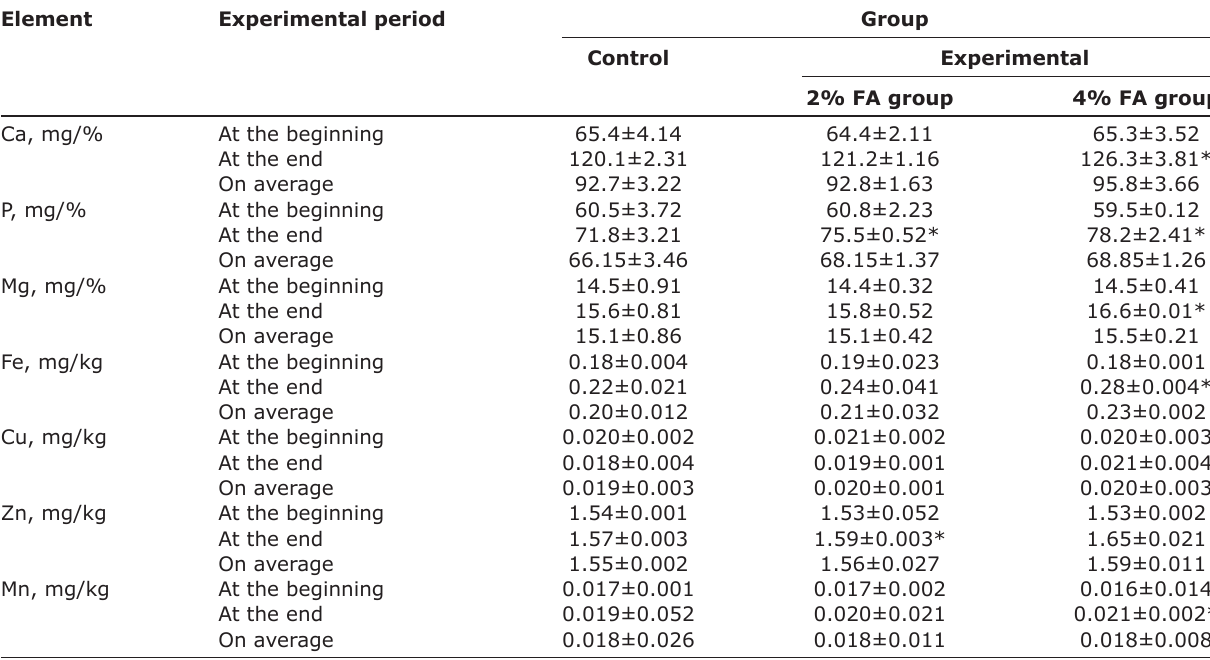
Table-5: Mineral content in cows’ milk, (M±m, n=10).